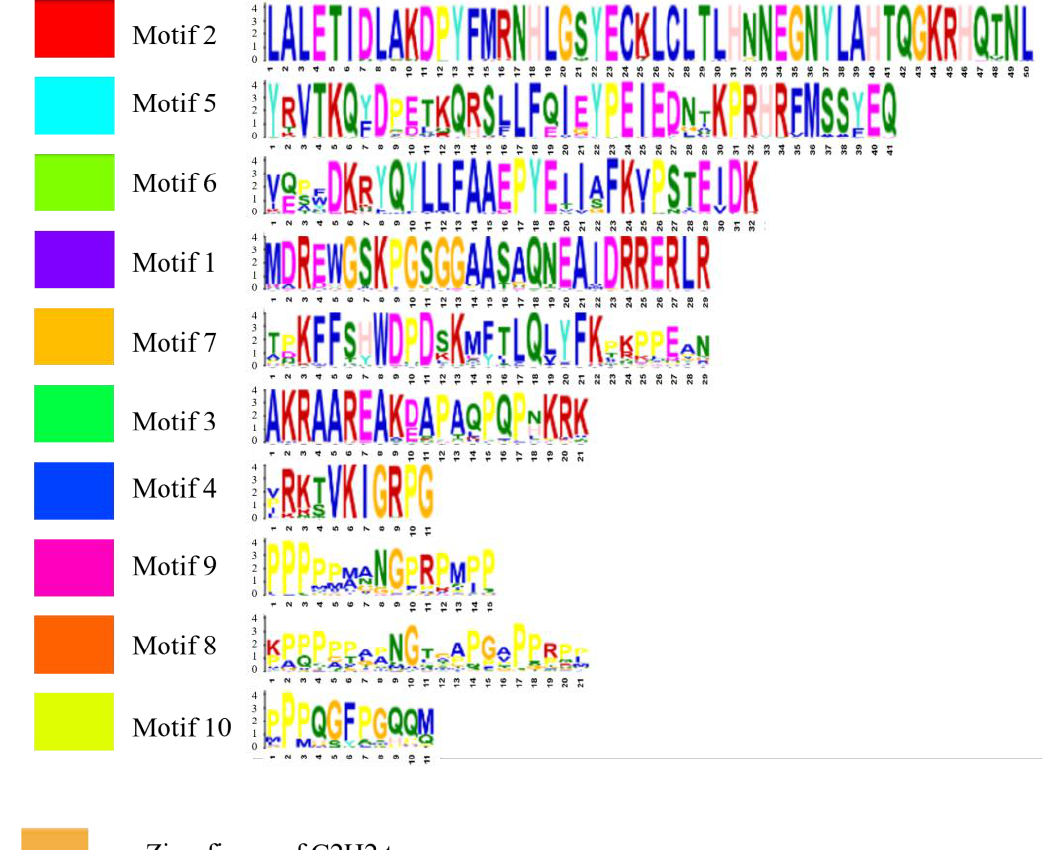
Figure 3. Protein domain and multiple Em for Motif Elicitation (MEME) analysis of plant SF3a2 proteins. The phylogenetic relationship, gene structure, and conserved motifs of cDNA sequences are listed on the picture ’ s left, middle, and right sides. The conserved sequences are listed below the image. The main protein domains are labeled below the picture.